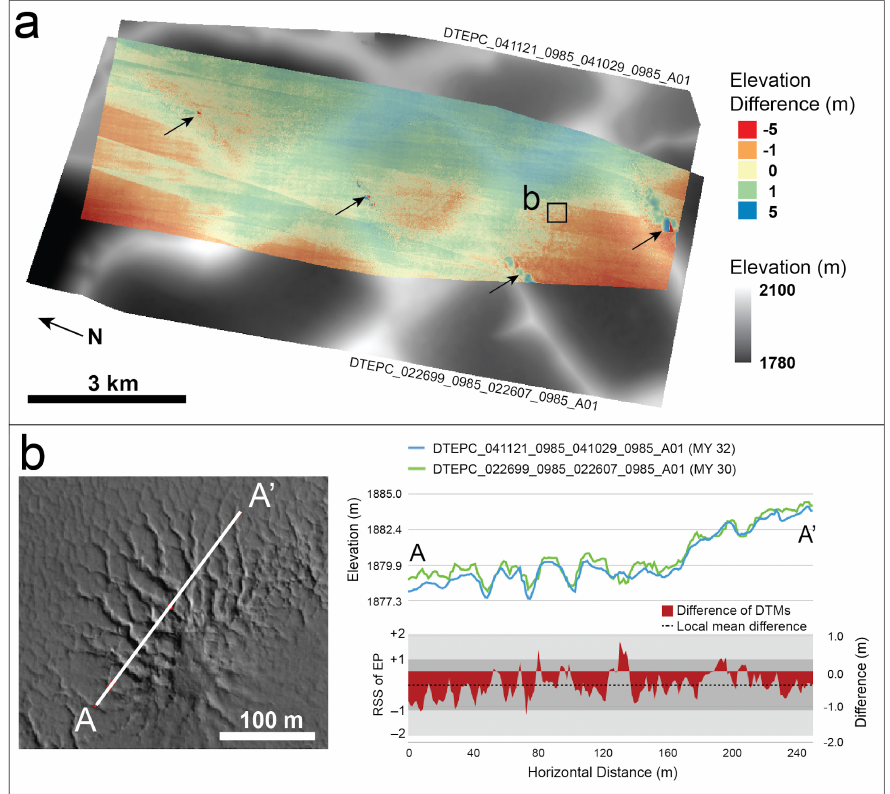
Figure 14. ( a ) Co-registered DTMs at the site dubbed Inca City (81.4 ◦ S, 295.8 ◦ E), with overlapping area in color showing the difference map. Overall, the elevation differences are within ± 1 m, indicat- ing a satisfactory alignment of the two stereo models. Black arrows indicate interpolation artifacts due to dark shadows where the stereo correlator failed (e.g., Figure 4c). ( b ) Detail of orthophoto ESP_041121_0985, located at the small black square in ( a ), showing an araneiform with no apparent changes between MY 30 and MY 32. Profile A–A’ is shown from both DTMs. Locally, the differences between the two models are <1 m, with a mean difference of − 0.39 m. Gray shaded regions on the difference plot illustrate ± 1 and 2 × RSS EP of both DTMs about the local mean difference.